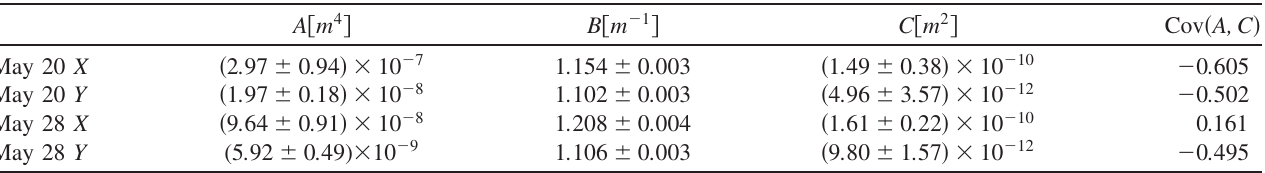
TABLE III. Results of fitting parabolas to the squares of the horizontal and vertical beam sizes.